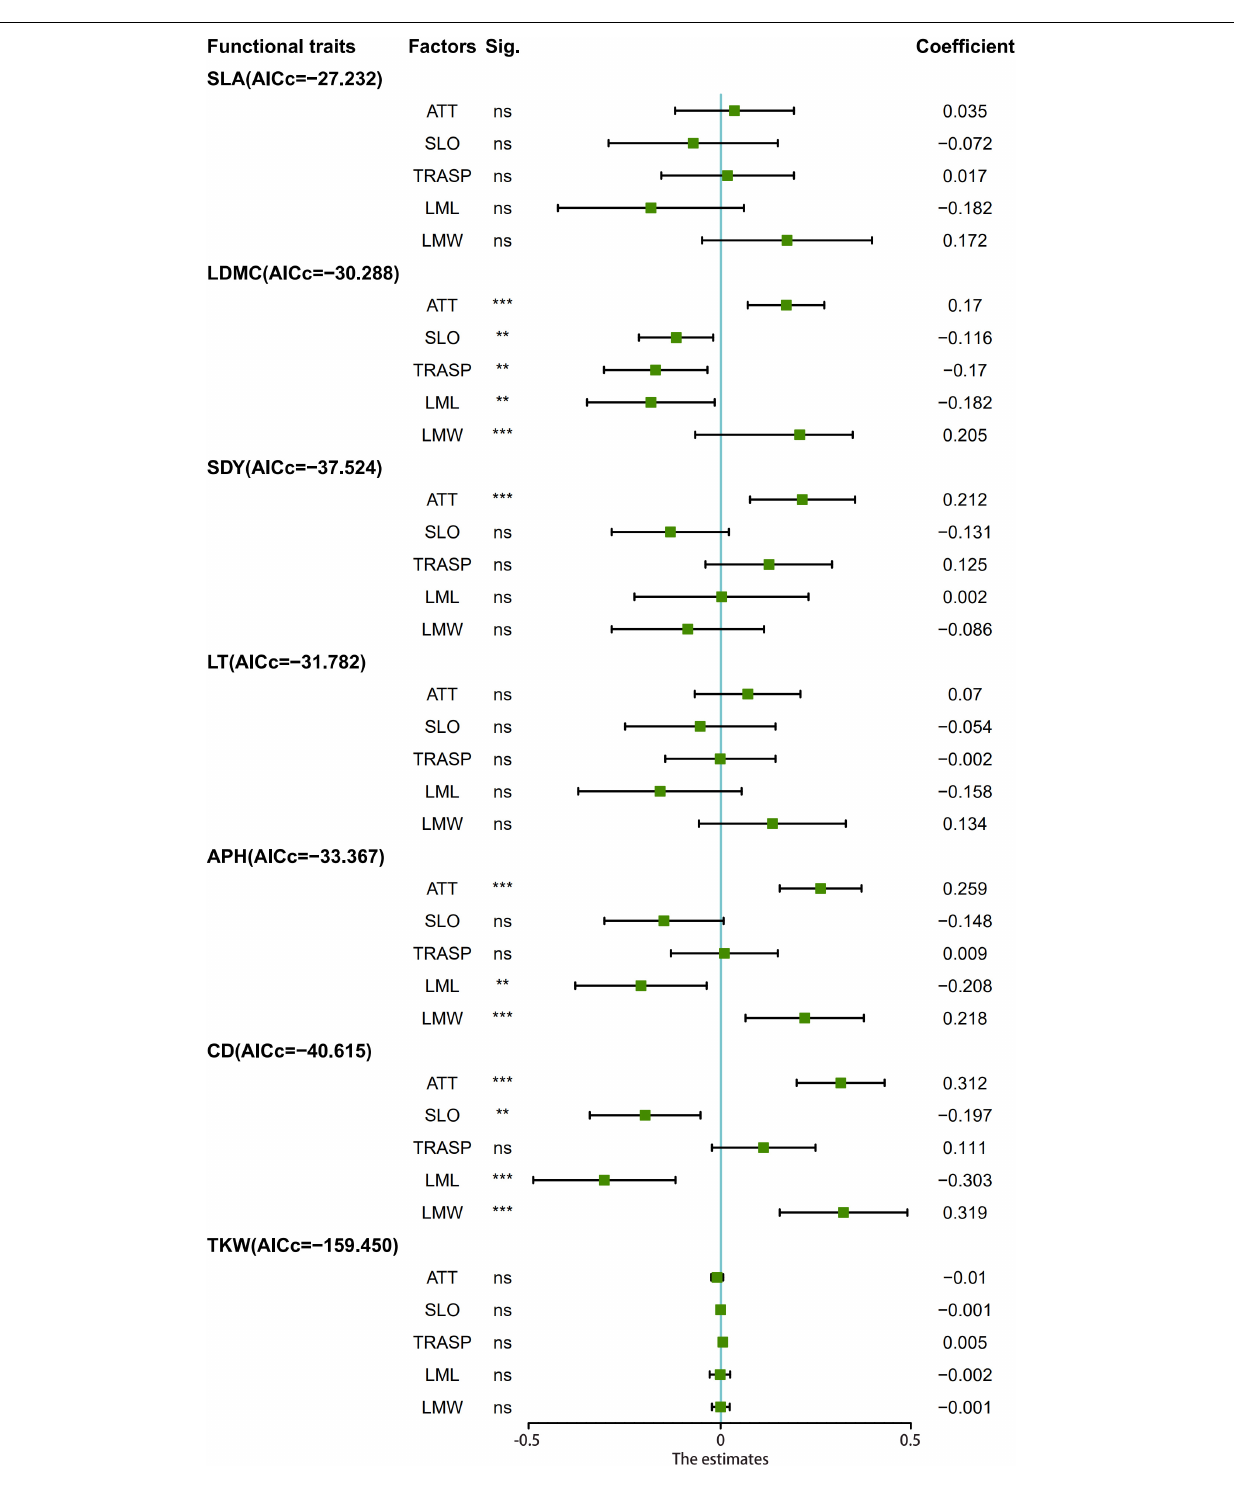
Frontiers in Ecology and Evolution |